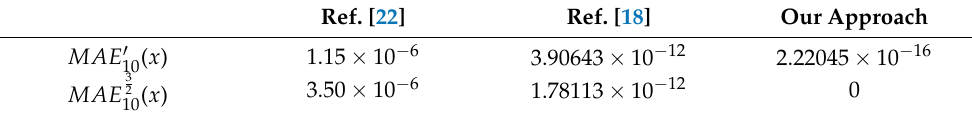
Table 2. MAEs for Example